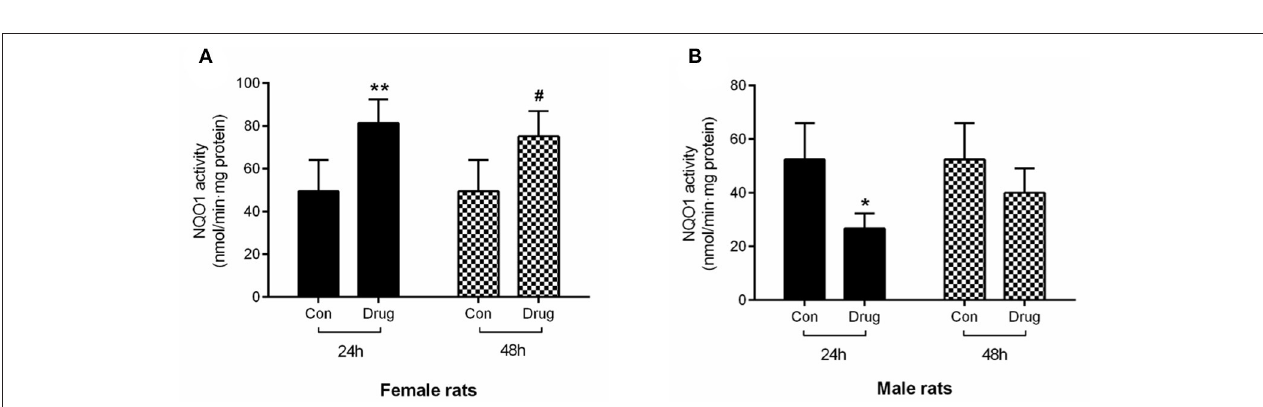
FIGURE 4 | Assessment of in vivo NQO1 activity in female rats (A) and male rats (B) following intragastric administered with M. cordata extracts. Con, Control group; Drug, administrated with M. cordata extracts. * / # P < 0.05, ** / ## P < 0.01 vs. respective control group of female and male rat.